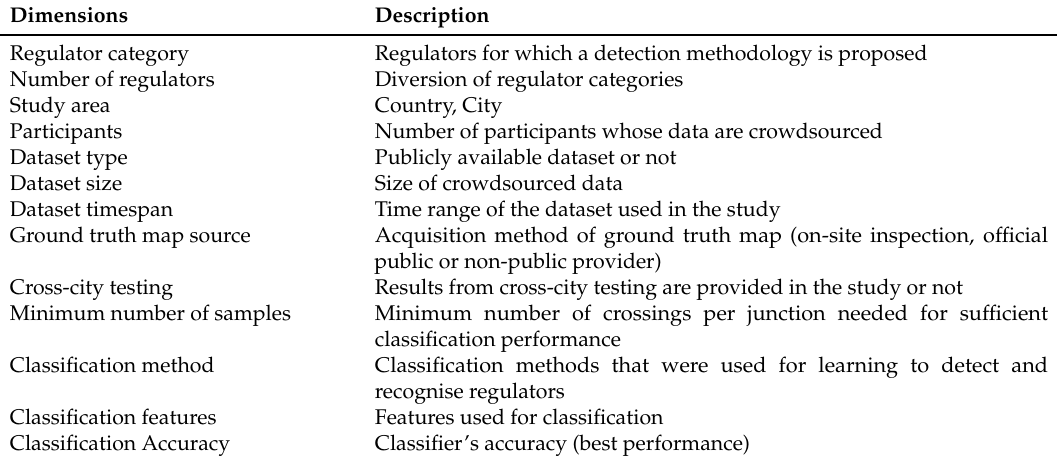
Table 6. Comparison aspects (dimensions) of the reviewed articles in terms of their proposed methods, experimental settings and